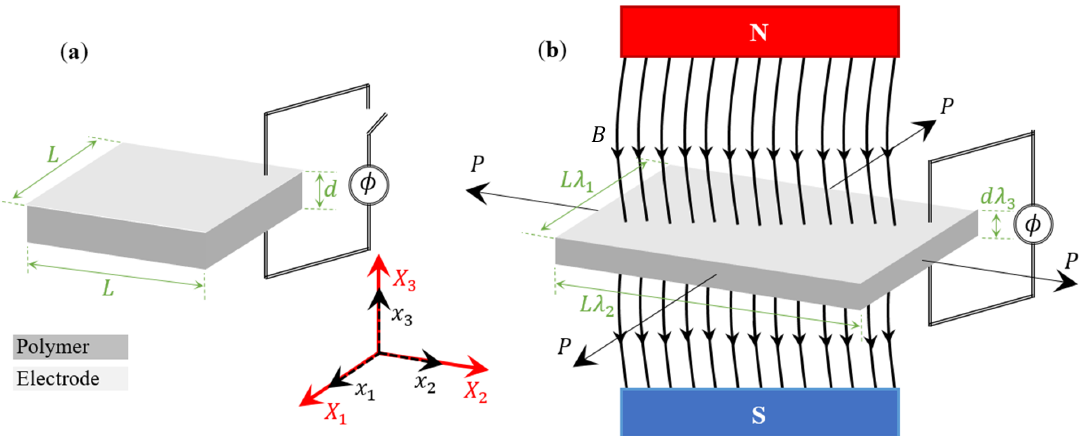
Figure 1. The schematic of magneto/electroactive model ( a ) without external stimuli and ( b ) actuated with magnetic, electrical, and mechanical stimulants; Reference configuration in red ( X 1 , X 2 , X 3 ) and Actuated deformed configuration in black arrows ( x 1 , x 2 , x 3 )